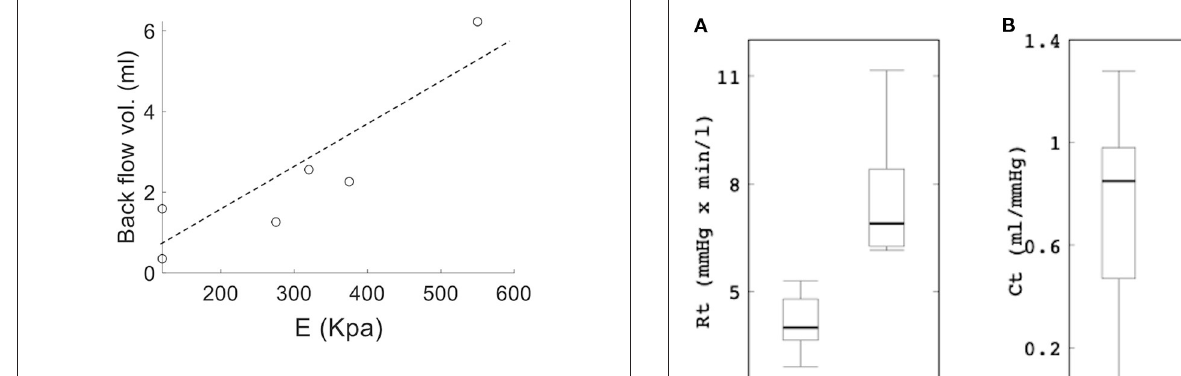
FIGURE 5 | Volume of the total regurgitant flow over a cardiac cycle vs. linearized stiffness E for all PAH patients showing a linear correlation ( r P 0.018). =